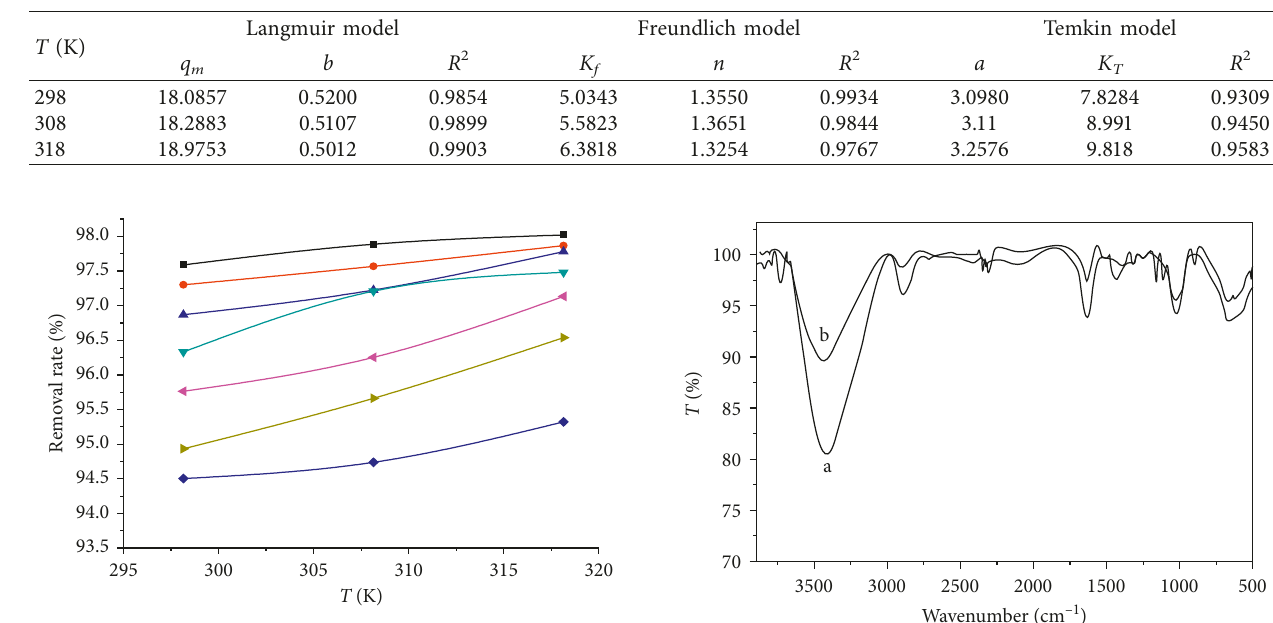
Table 3: Parameters of different isothermal models of uranium(VI) adsorption by rice stem.